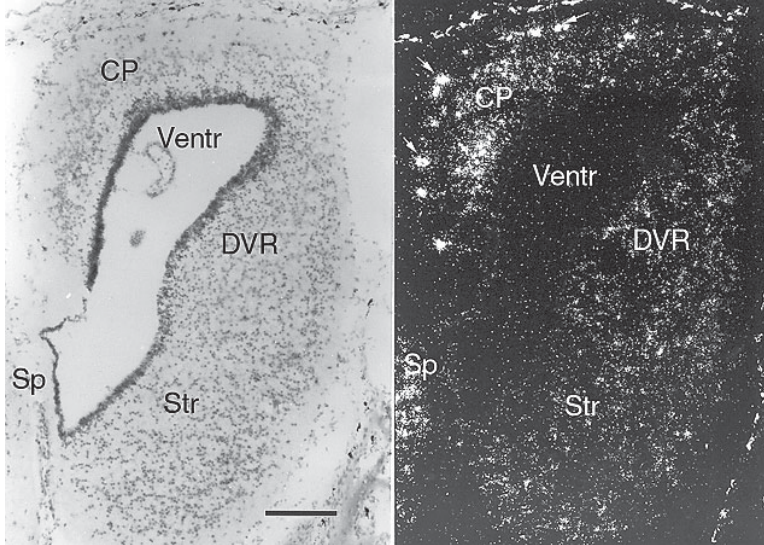
Figure 4. Reelin mRNA expression in the turtle embryonic cortex. Bright and dark field view of a coronal section through a turtle embryo ( Emys orbicularis ). In situ hybridization with a [ 33 P]-labeled, species-specific reelin riboprobe. The poor laminar organization of the cortical